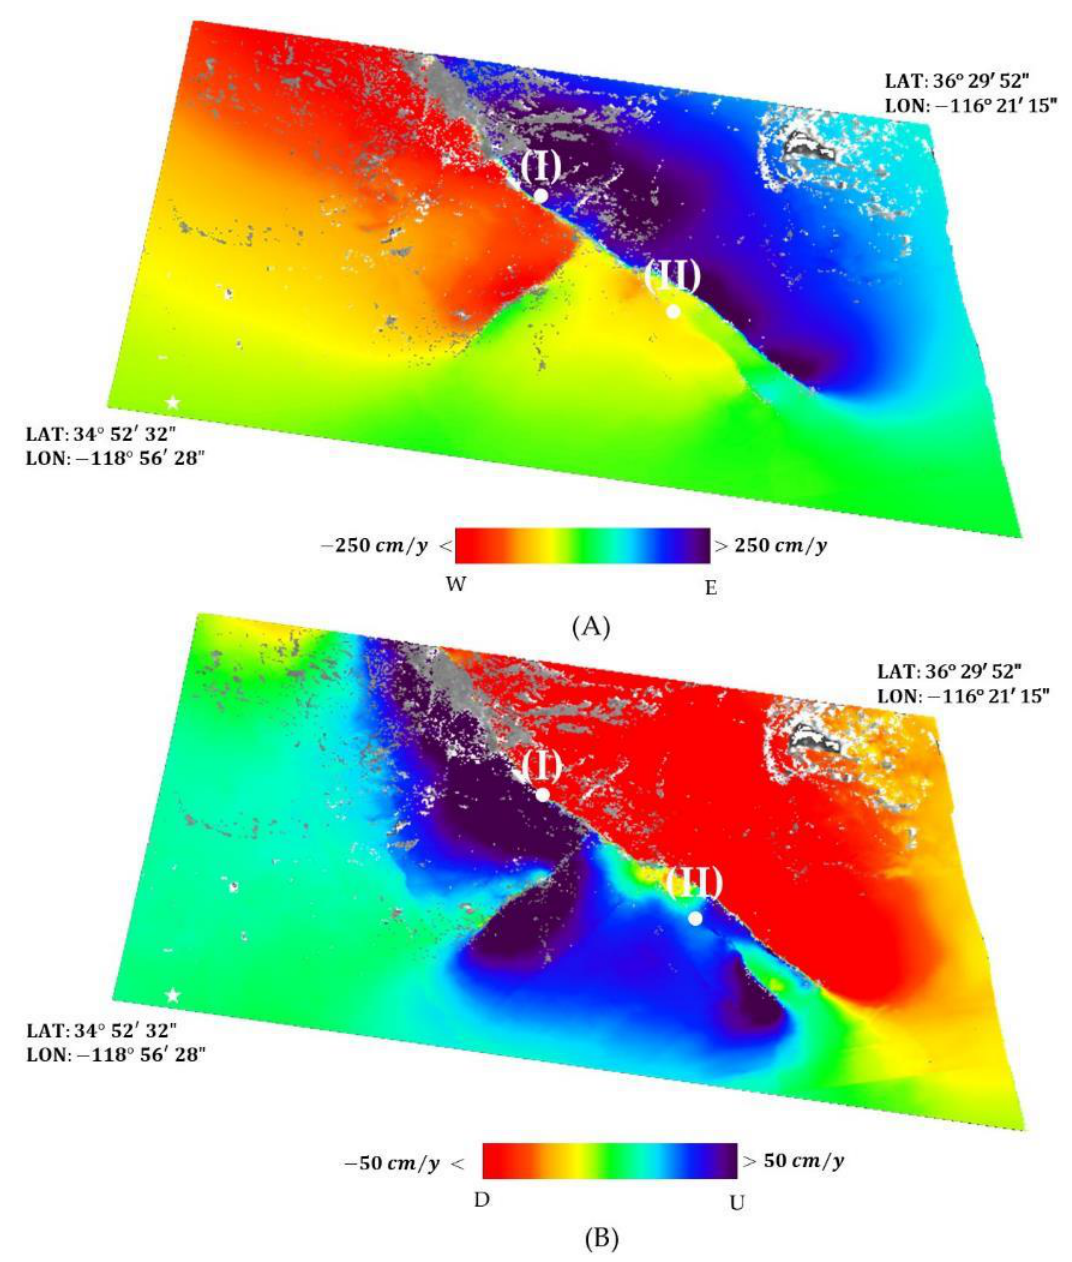
Figure 25. Geocoded mean displacement maps along the east–west and the up–down directions of the Ridgecrest area, superimposed on an amplitude image. The labels (I) and (II) in white indicate two points across the fault where the east–west and the up–down displacement time-series have been estimated, respectively. All displacement measurements are evaluated with respect to a pixel, identified in (A) and (B) by a white star.